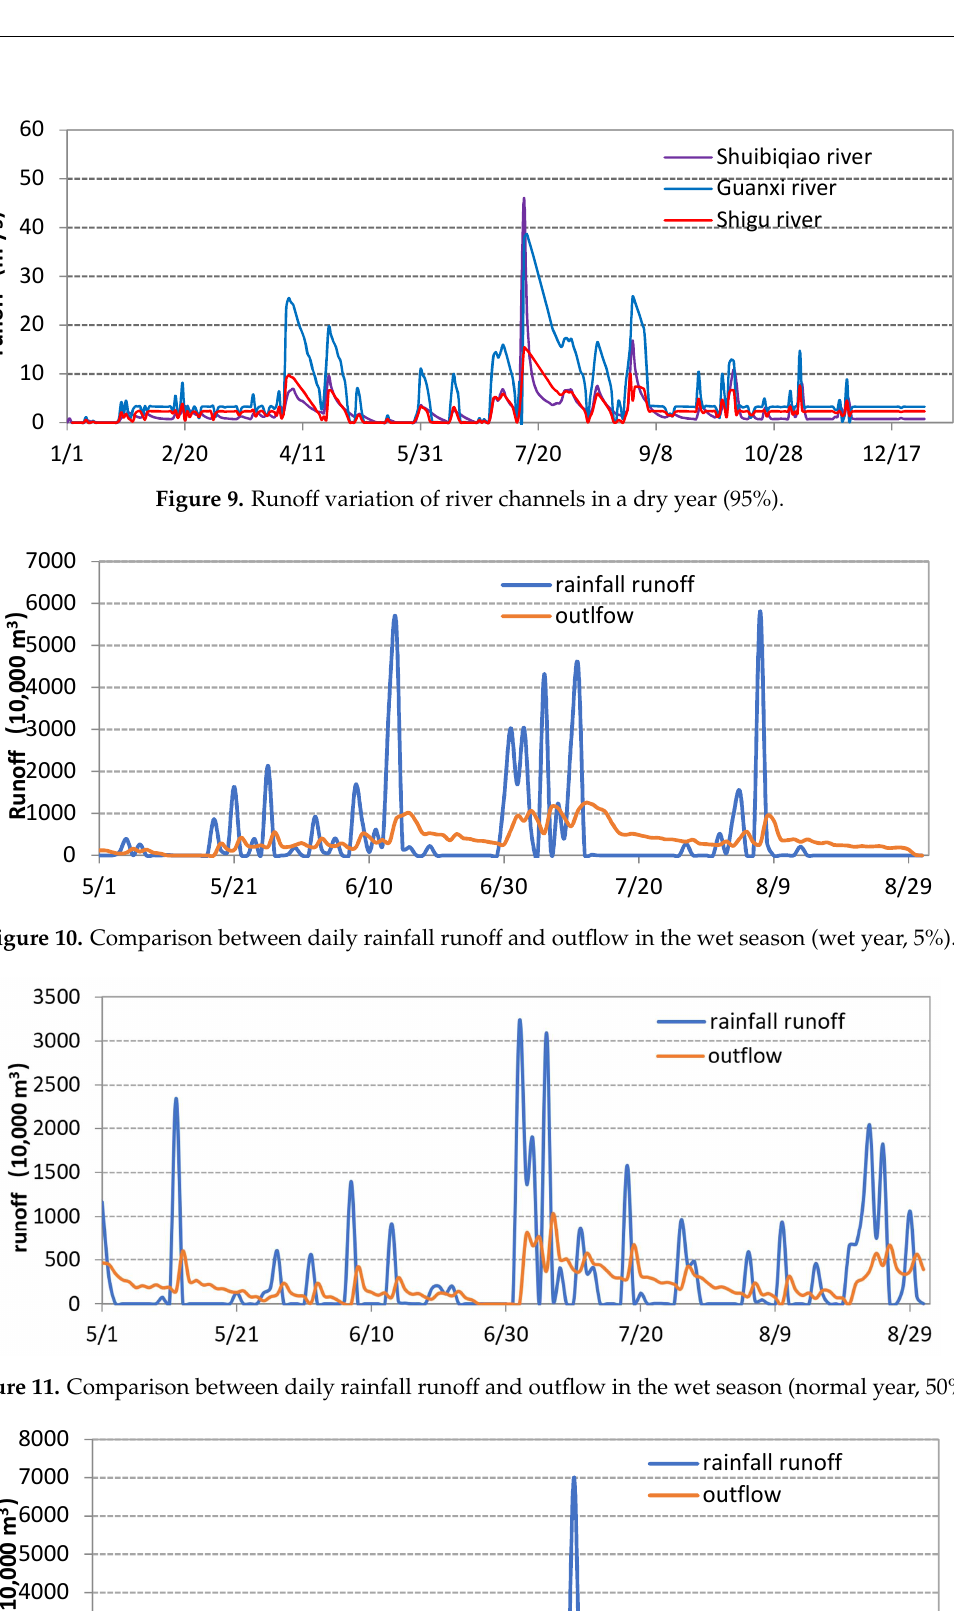
13 of 16 Figure 7. Runoff variation of river channels in a wet year (5%).